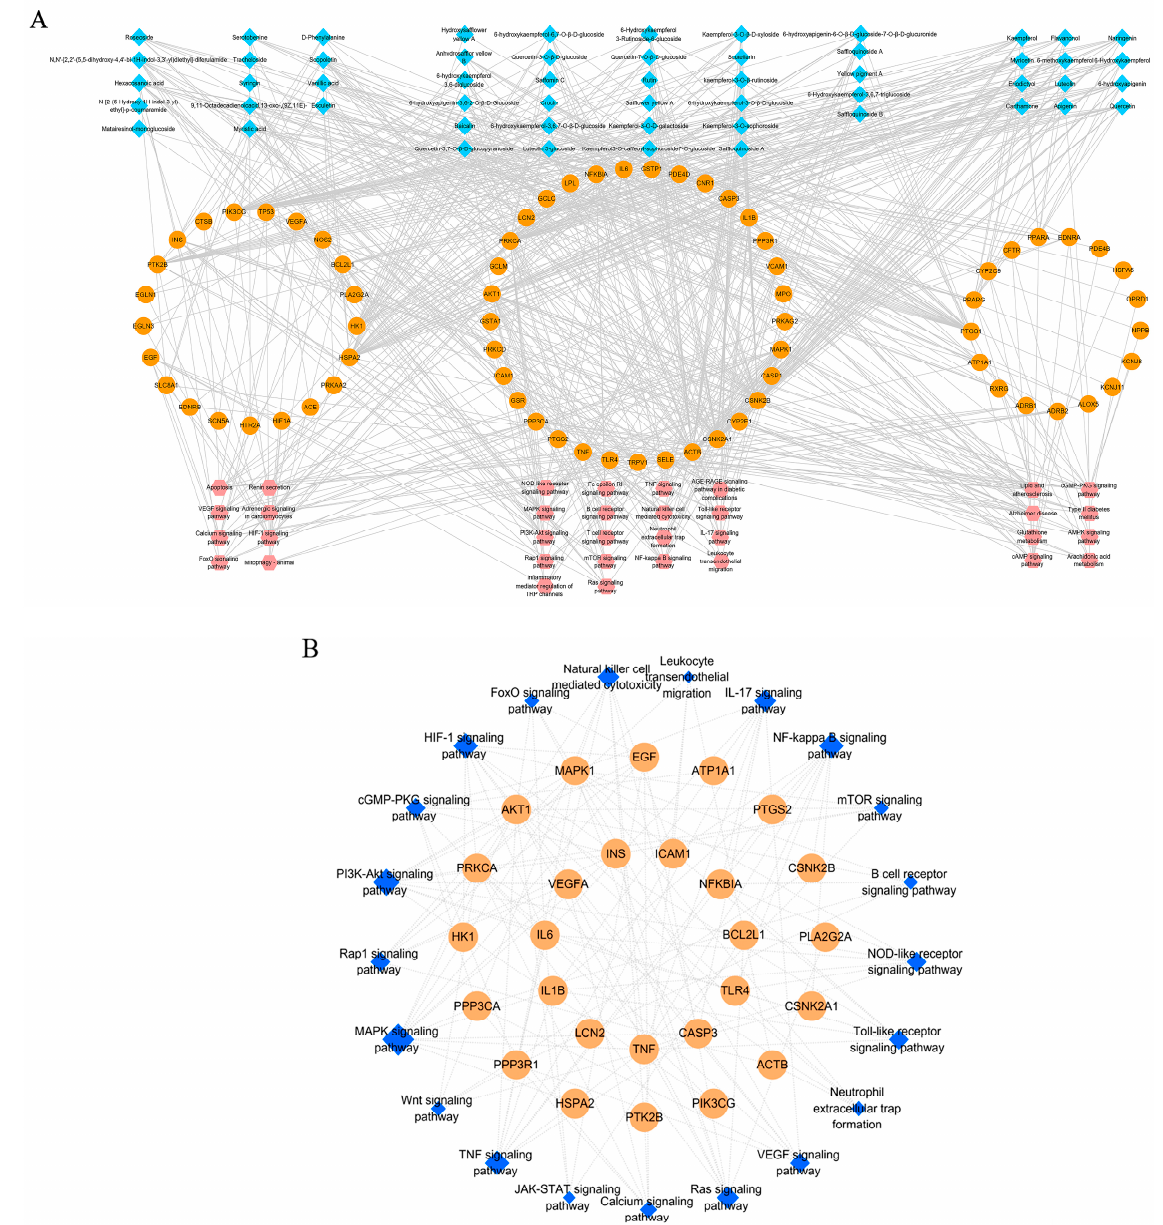
Figure 5. The interactive network of “components-targets-pathways-symptoms” ( A ) was shown. The network of hub targets and key pathways ( B ) were also shown. In ( A ), yellow nodes refer to the safflower, blue nodes refer to putative targets of safflower, orange nodes refer to therapeutic targets of MIR, and pink nodes refer to KEGG pathway. In ( B ), orange nodes refer to hub targets filtered from ( A ), and the blue one refers to the key